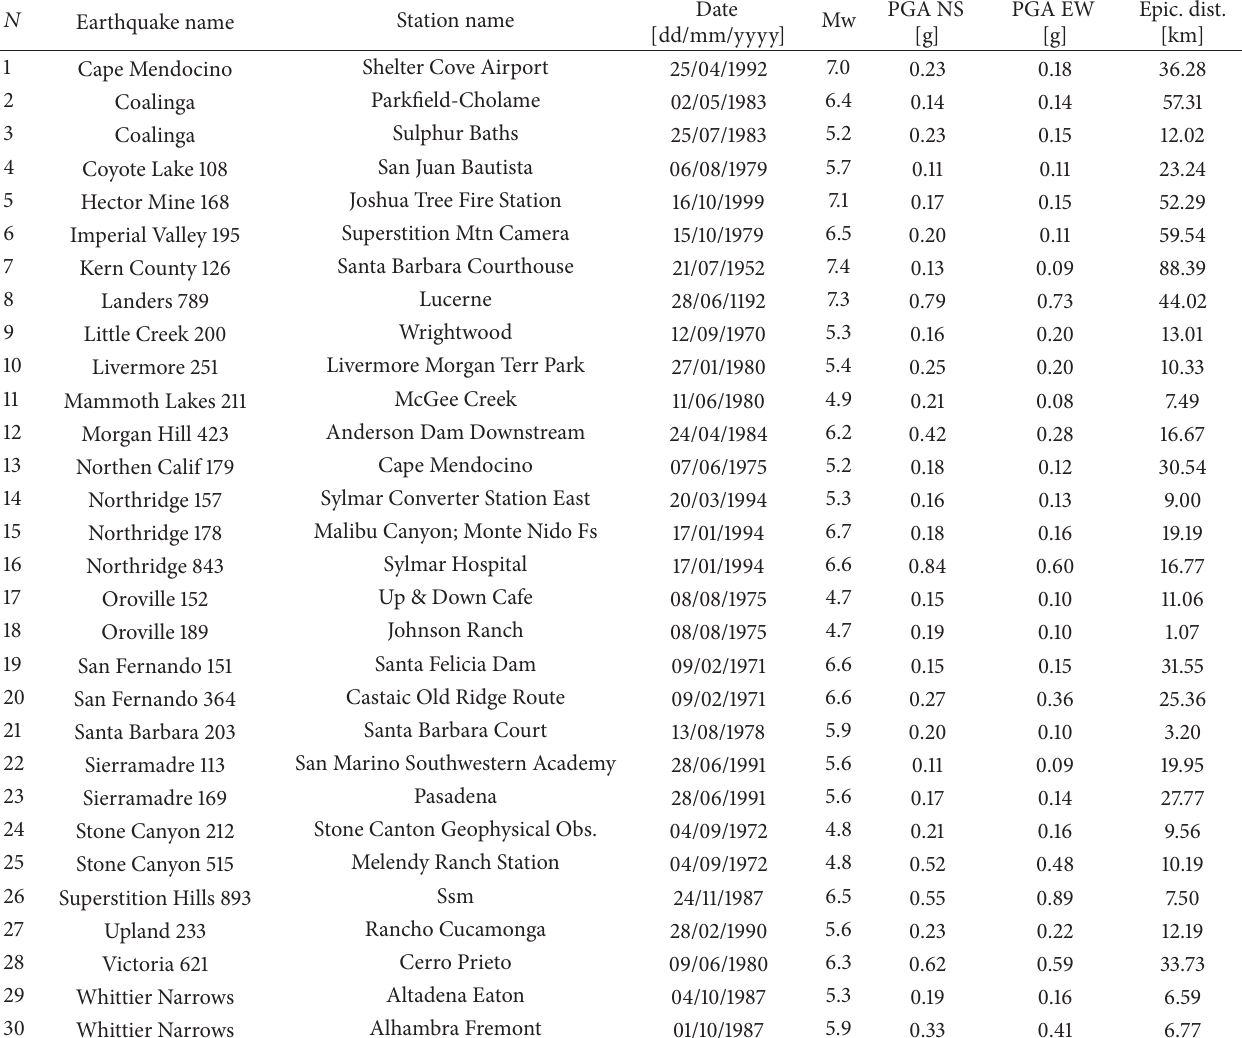
Table 3: The Californian ground motions selected for the analyses (PEER database